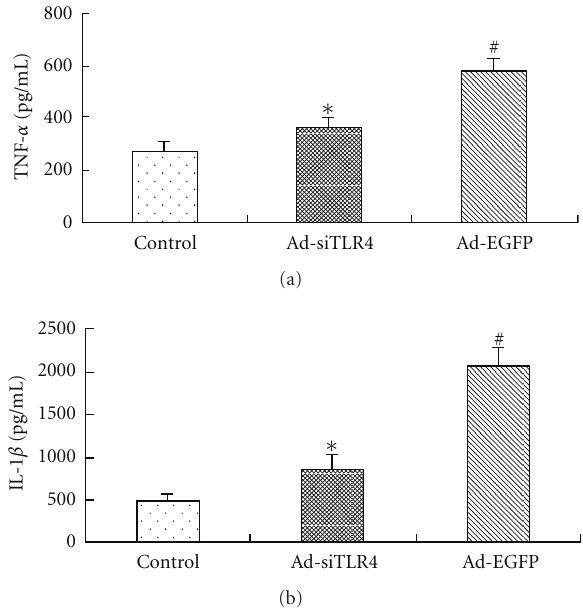
Figure 4: E ff ect of Ad-siTLR4 transfection on the expression of proinflammatory cytokines in the lung of ALI rats. The TNF- α (a) and IL-1 β (b) were determined by ELISA at 4h after LPS administration. Data were expressed as fold change when compared with saline-treated animals. ∗ P < 0 . 05 versus Ad-EGFP group, # P < 0 . 05 versus control group. ALI or ARDS is one of clinical conditions associated with sepsis in humans and characterized by the